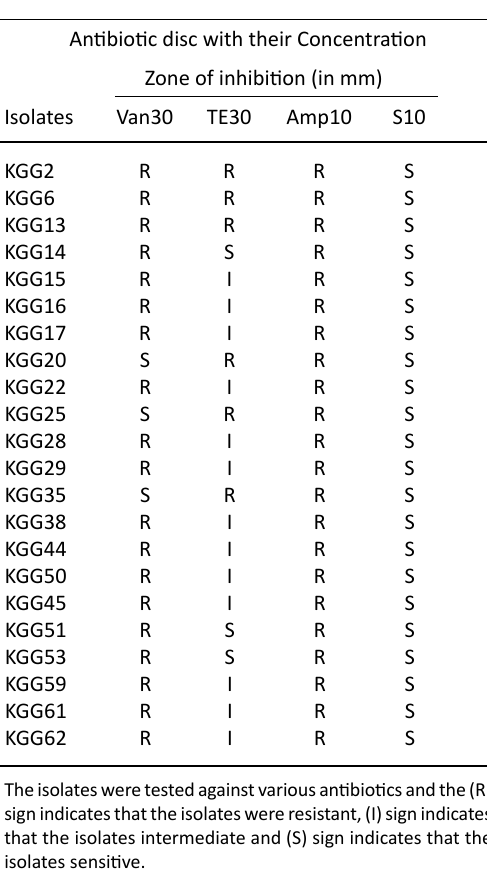
Table 4. Antibiotic Assay of the bacterial isolates Antibiotic disc with their Concentration